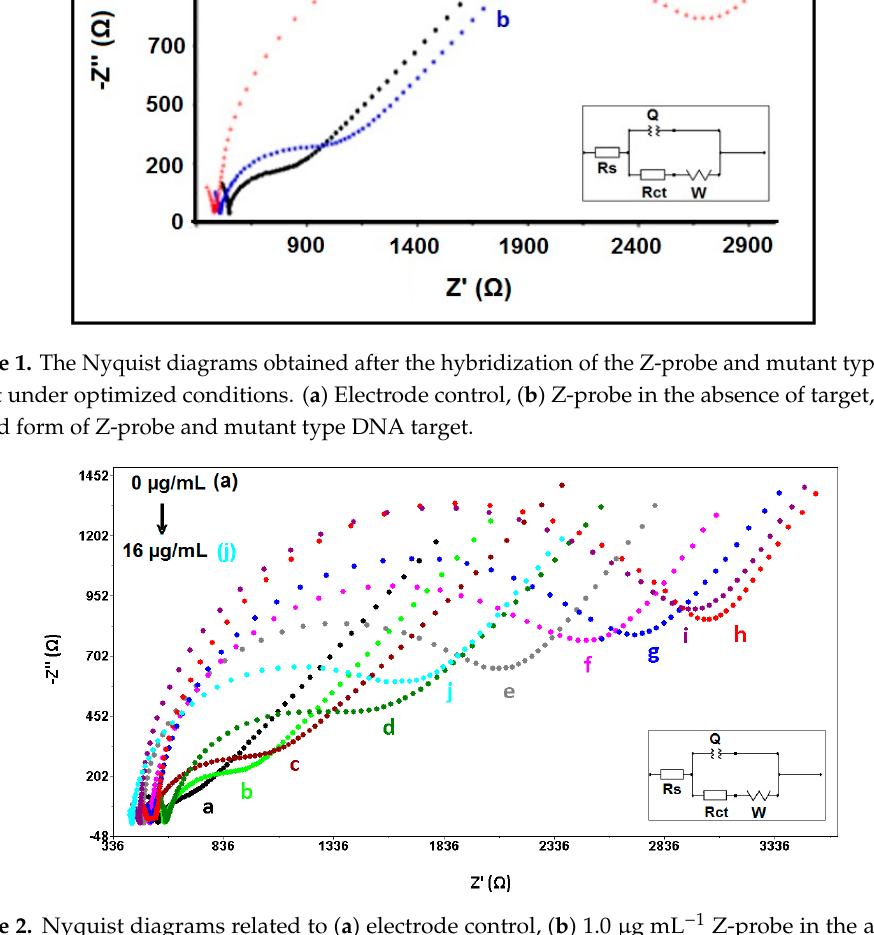
Figure 1. The Nyquist diagrams obtained after the hybridization of the Z-probe and mutant type DNA target under optimized conditions. ( a ) Electrode control, ( b ) Z-probe in the absence of target, ( c ) the hybrid form of Z-probe and mutant type DNA target.